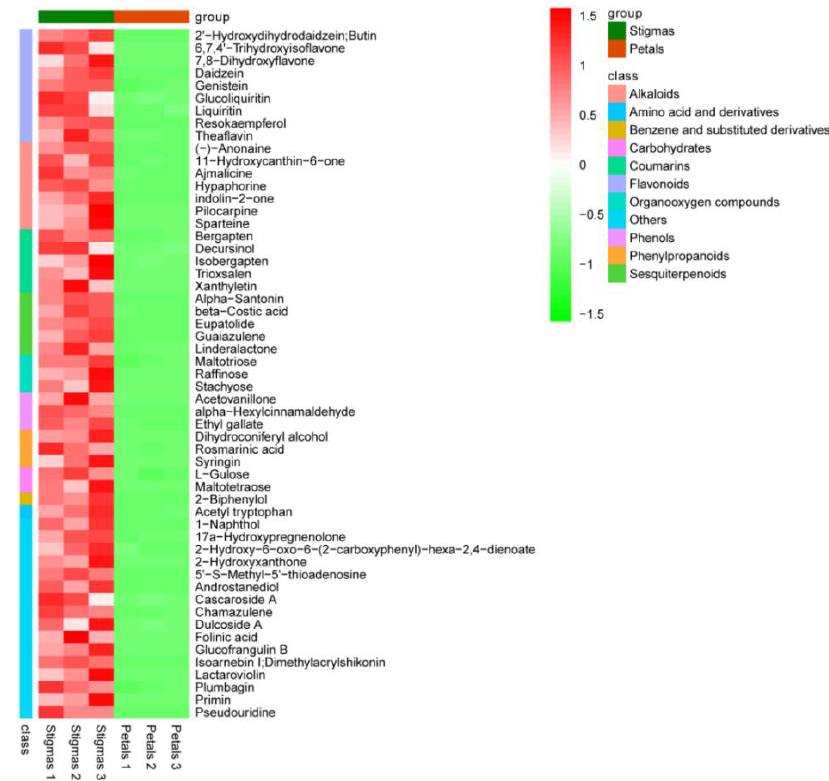
Figure 6. Heat map of the top 55 down-regulated metabolites.